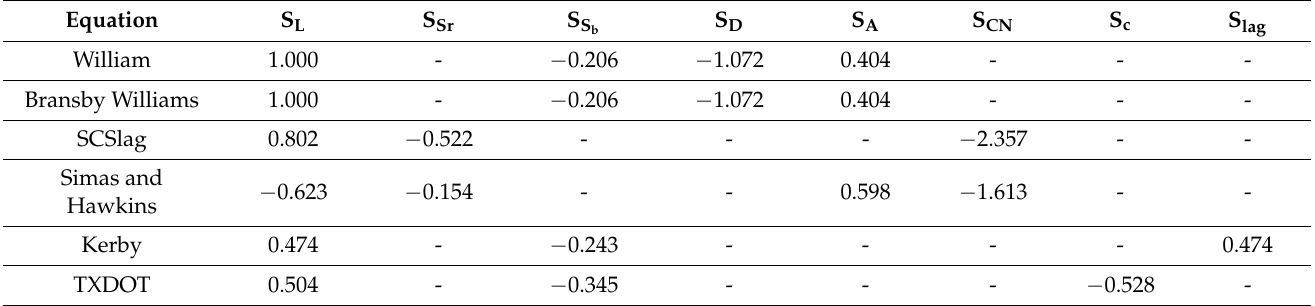
Table 8. Sensitivity coefficients of the methods based on S b , C , CN and D (category II).